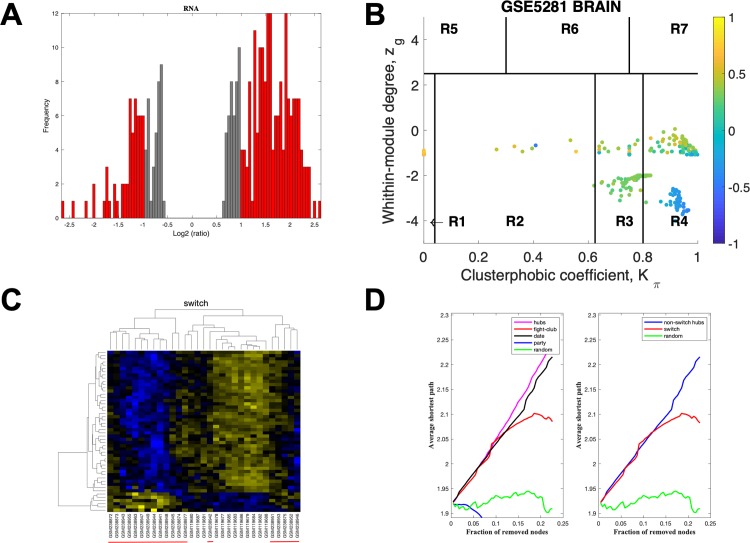
SWIM analysis of the primary visual cortex.A. Distribution of the fold-change values for GSE5281 brain microarray gene expression data from the VCX. The x-axis represents the fold-change value (log2 of the fold-change) that is the ratio of the average expression data in AD patients compared to the average expression data in normal controls computed for protein-coding and non-coding RNAs. The y-axis represents the frequency of the obtained fold-change values. The grey bars represent the fold-change values associated with protein-coding and non-coding RNAs that will be discarded according to the selected threshold. The red bars represent the fold-change values associated with protein-coding and non-coding RNAs that were retained for further analysis. B. Heat cartography map for GSE5281 brain data from the VCX. correlation network. The plane is identified by two parameters: Zg (within-module degree) and Kπ (clusterphobic coefficient) and it is divided into seven regions each defining a specific node role (R1-R7). High Zg values correspond to nodes that are hubs within their module (local hubs), whereas low Zg values correspond to nodes with few connections within their module (non-hubs within their communities, but they could be hubs in the network). Each node is colored according to its average Pearson Correlation coefficient (APCC) value. Yellow nodes are party and date hubs, which are positively correlated in expression with their interaction partners. Blue nodes are the fight-club hubs, which have an average negative correlation in expression with their interaction partners. Blue nodes falling in the region R4 are the switch genes, which are characterized by low Zg and by high Kπ values and are connected mainly outside their module. C. Dendrogram and heat map for switch genes in GSE5281 brain microarray gene expression data from the VCX. The expression profiles of switch genes (including protein-coding and non-coding RNAs) are clustered according to rows (switch genes) and columns (samples) of the switch genes expression data (biclustering). The colors represent different expression levels that increase from blue to yellow. The red line under the x axis labels denotes AD samples. D. Robustness for the GSE5281 brain correlation network from the VCX. The x-axis represents the cumulative fraction of removed nodes, while the y-axis represents the average shortest path. The shortest path between two nodes is the minimum number of consecutive edges connecting them. Each curve corresponds to the variation of the average shortest path of the correlation network as function of the removal of nodes specified by the colors of each curve.